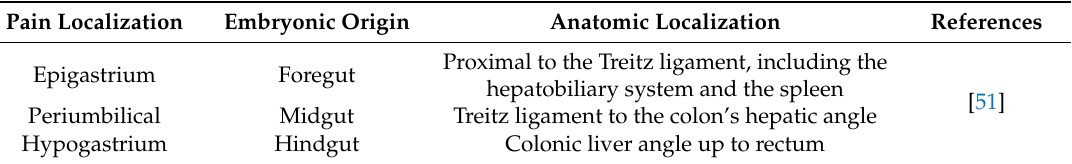
Table 3. Topography and origin of abdominal pain.